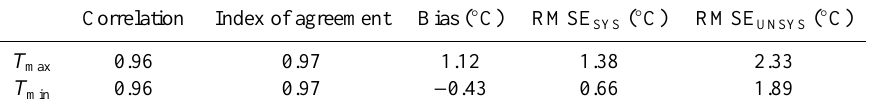
Table 2. Performance statistics for daily maximum ( T max ) and minimum ( T min ) near-surface air temperature, obtained from the “urban” scenario, based on formulas by Wilmott (1982). RMSE SYS and RMSE UNSYS are the systematic and unsystematic root mean square error, respectively.